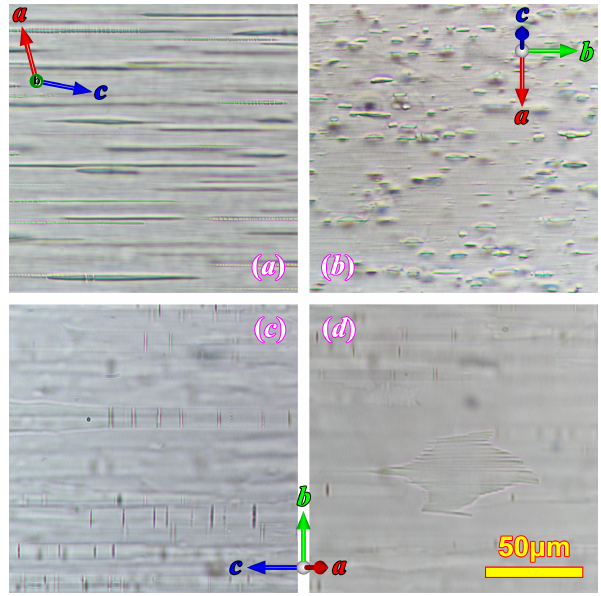
Figure 3. Plagioclase exsolution lamellae in the RLS under optical microscope in plane polarized light. The crystallographic orienta- tion of the orthoclase matrix is marked on each image.